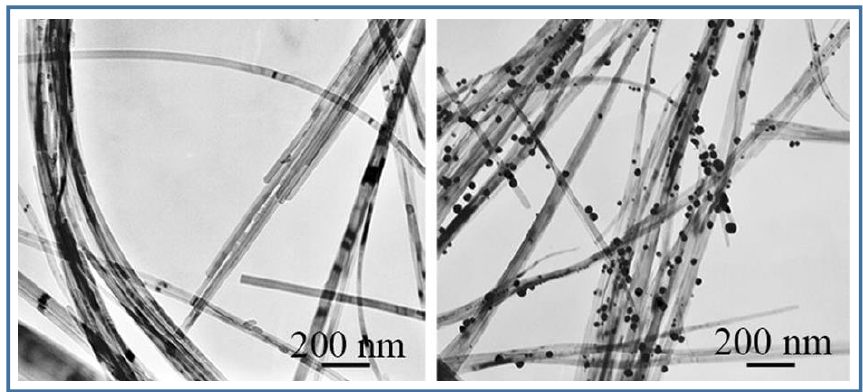
Figure 5. TEM micrographs of HAp nanowires with ( right ) and without ( left ) Ag nanoparticles